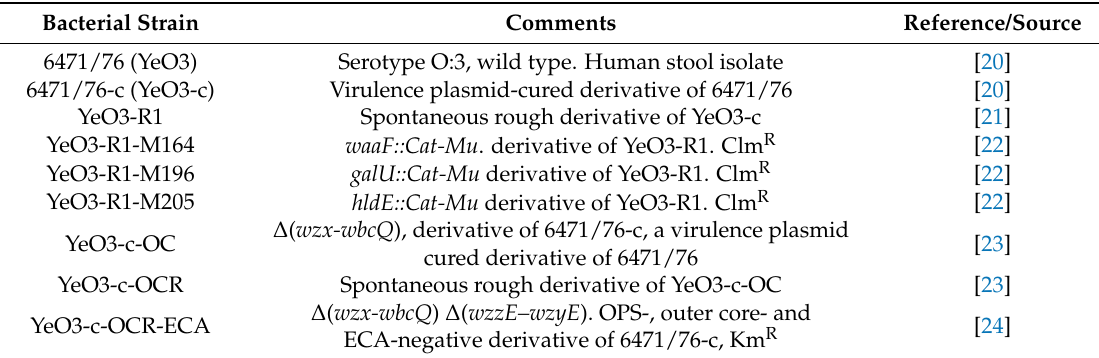
Table 1. Bacterial strains used in this